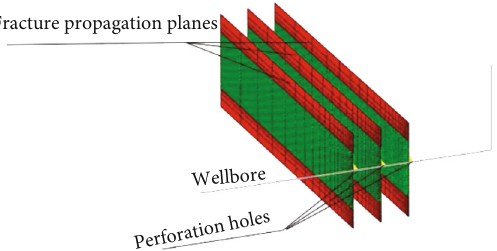
Figure 3: A plane of COH3D8P elements was embedded in the C3D8P elements at each perforation cluster to simulate